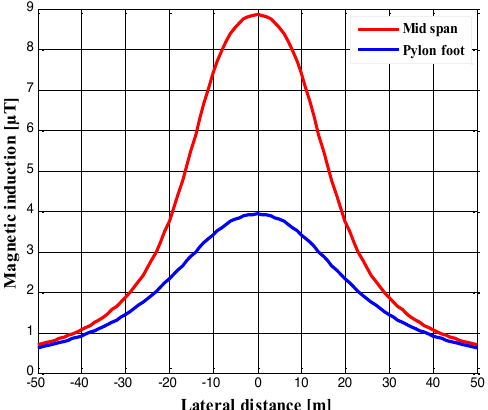
Figure 12: Magnetic induction profile at mid-span and pylon foot at 1 m above ground level. adjacent pylons, the height of the conductors at mid-span